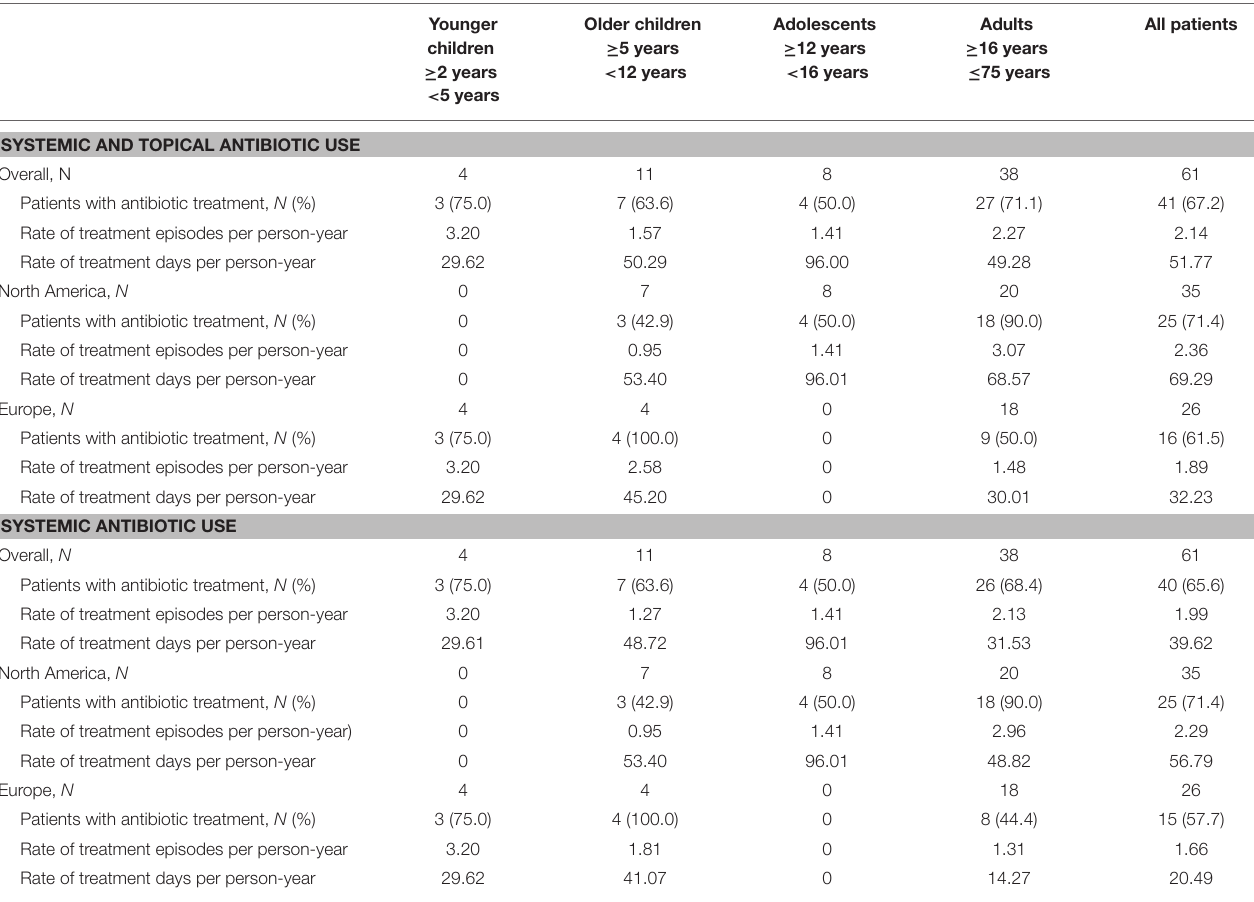
TABLE 4 | Systemic and topical antibiotic use, overall and by